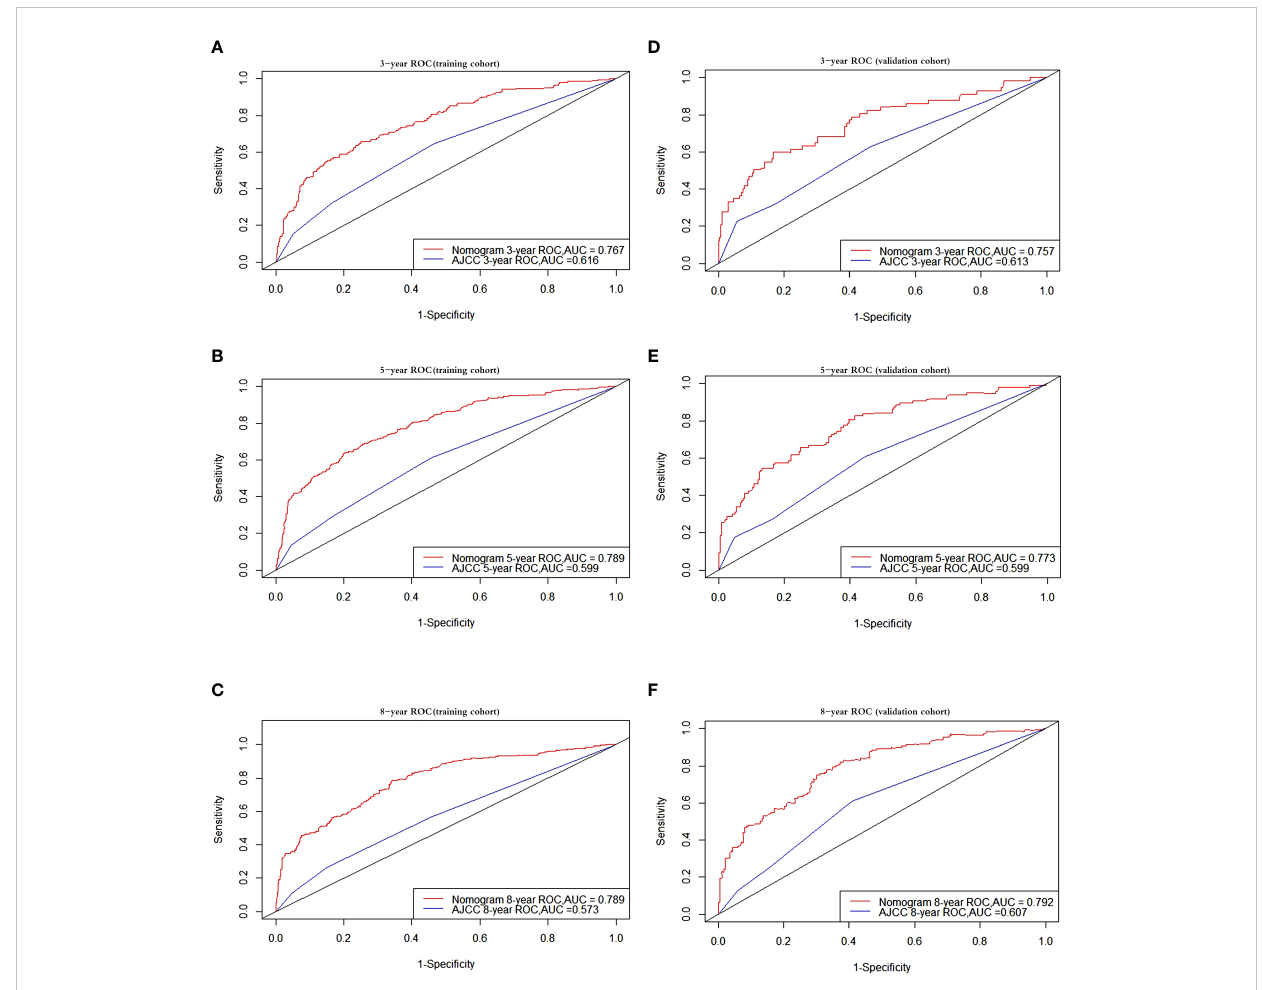
FIGURE 3 Receiver operating characteristic curves. ROC curve analyses to evaluate the performance of the new model compared to the traditional AJCC model. The area under the curve (AUC) metric was used to predict the overall survival probability with 3-, 5-, and 8-years OS probability in the training and validation cohorts. The results of the training cohort represent in (A – C) while (D – F ) represent the results of validation cohort. OS, overall